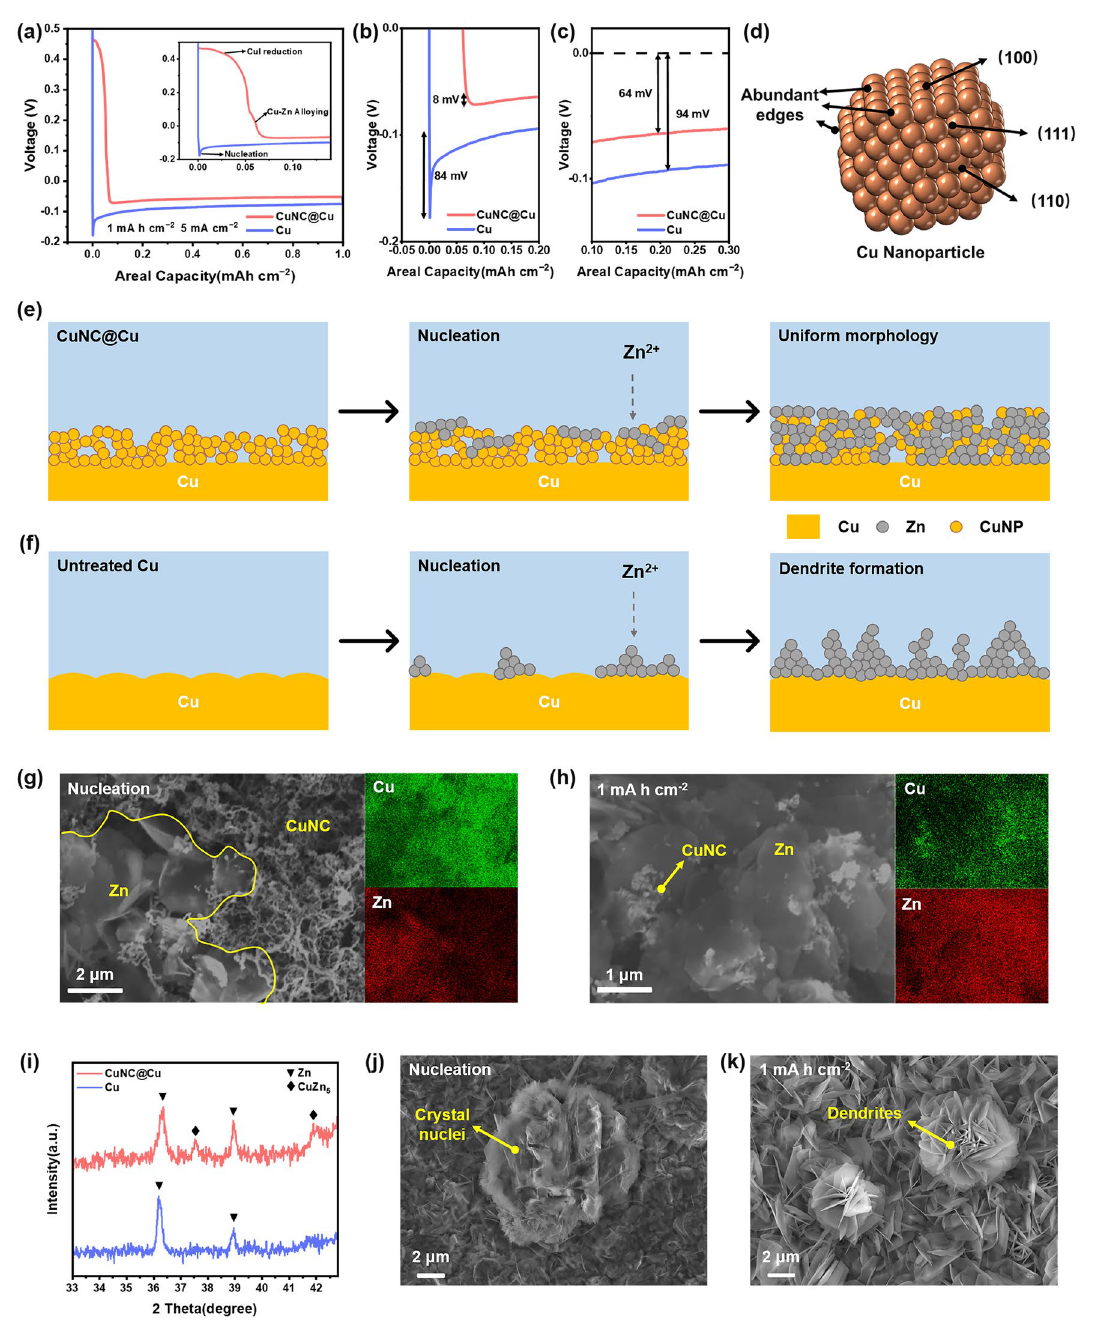
Fig. 3 a First-cycle galvanostatic deposition curve on CuNC@Cu and Cu electrodes at 5 mA cm −2 , and the inset shows the different deposition process of these two electrodes. Comparison of b nucleation overpotential and c deposition potential of CuNC@Cu and Cu electrodes at a cur- rent density of 5 mA cm −2 . d Schematic illustration of (100), (110), (111) planes and abundant facet edges of Cu nanoparticles. e–f Schematic illustrations of the Zn deposition behavior on CuNC@Cu and Cu electrodes. g–h SEM images and corresponding elemental mapping images of Zn deposition morphology on CuNC@Cu electrode at different deposition stages. i XRD patterns of CuNC@Cu and Cu electrode after deposi- tion for 12 min. j–k SEM images of Zn deposition morphology on Cu electrode at different deposition